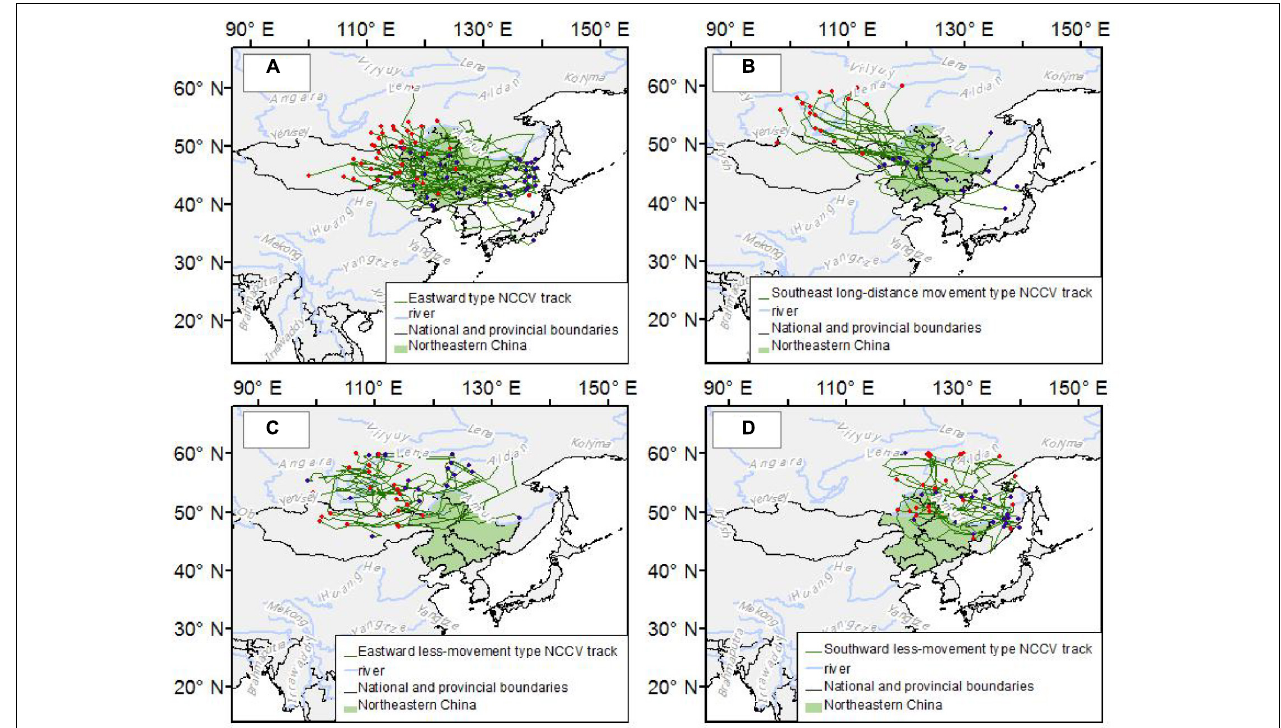
FIGURE 2 | Spatial distributions of the NCCV with four types of paths: (A) EM type; (B) SLM type; (C) ESM type; (D) SSM type.